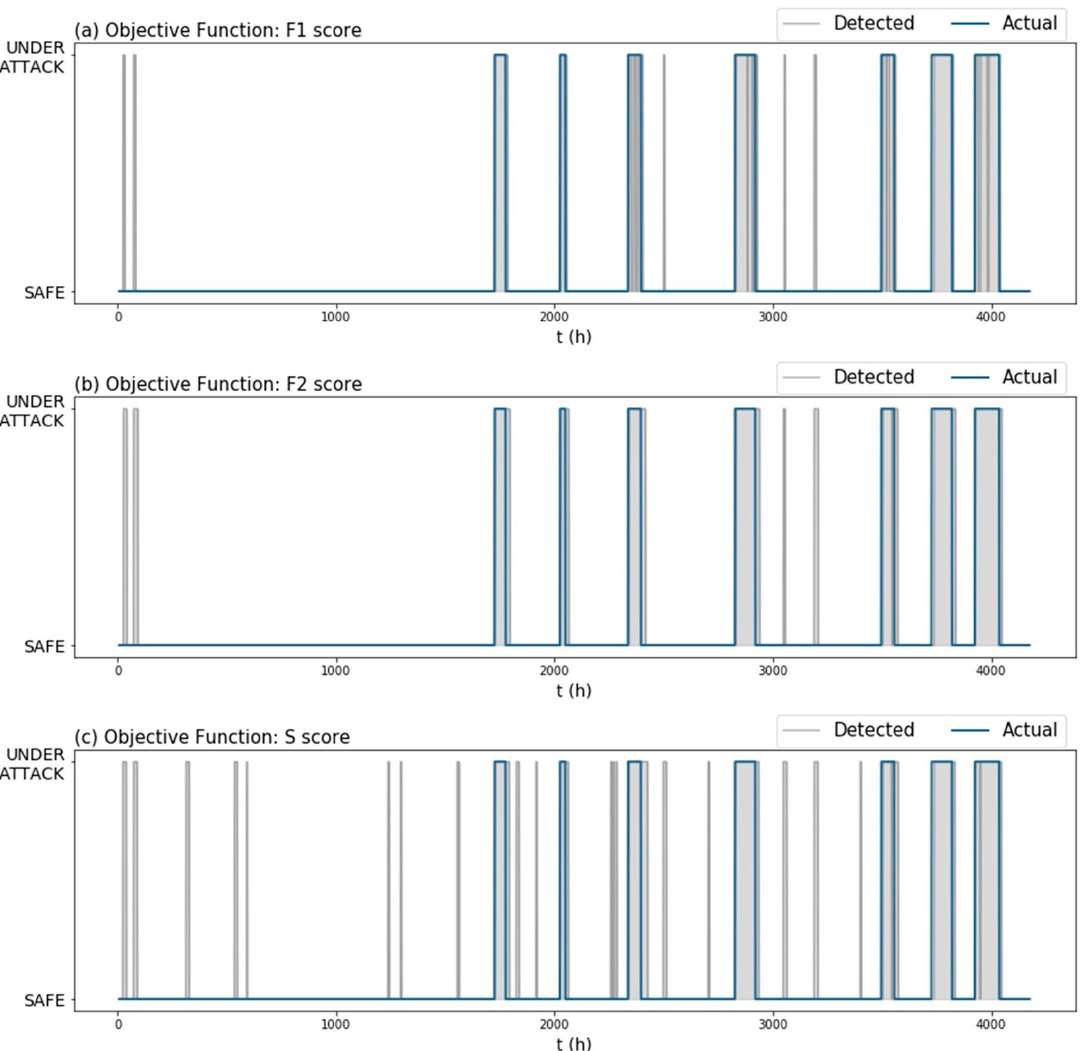
Figure 7. Graphic performance of the algorithm on the holdout set ( Dataset 2) using the same trained TGCN model, but different objective functions to fine-tune the attack detection threshold “ TH ” and rolling mean window length “ l ”. Objective functions used: ( a ) F 1 score, ( b ) F 2 score, ( c ) BATADAL S